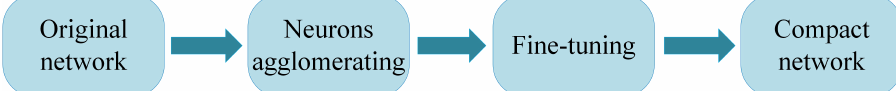
Figure 3. The process of the network compression based on neuron agglomerative